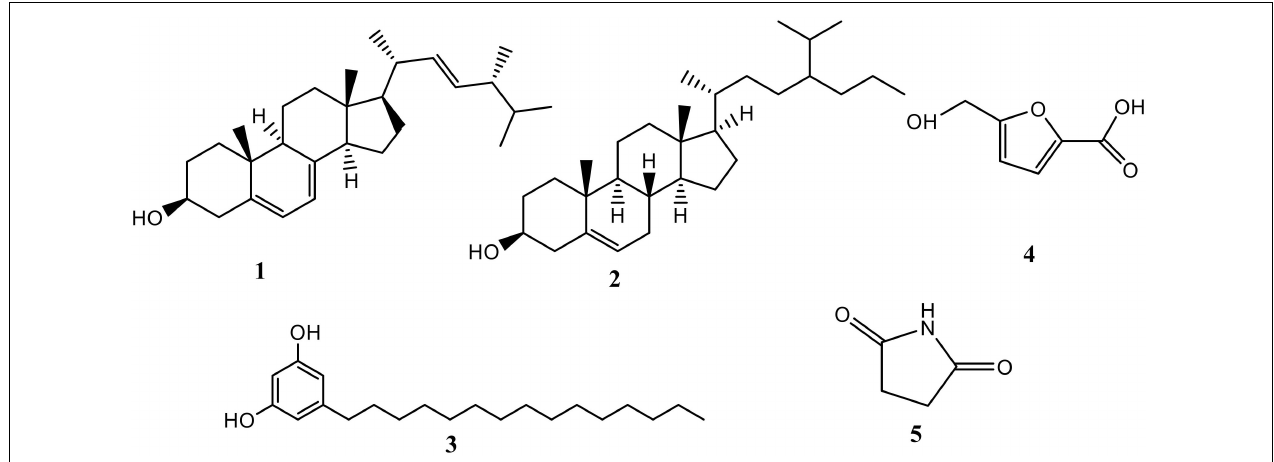
FIGURE 4 | The chemical structures of compounds isolated from A. niger xj.